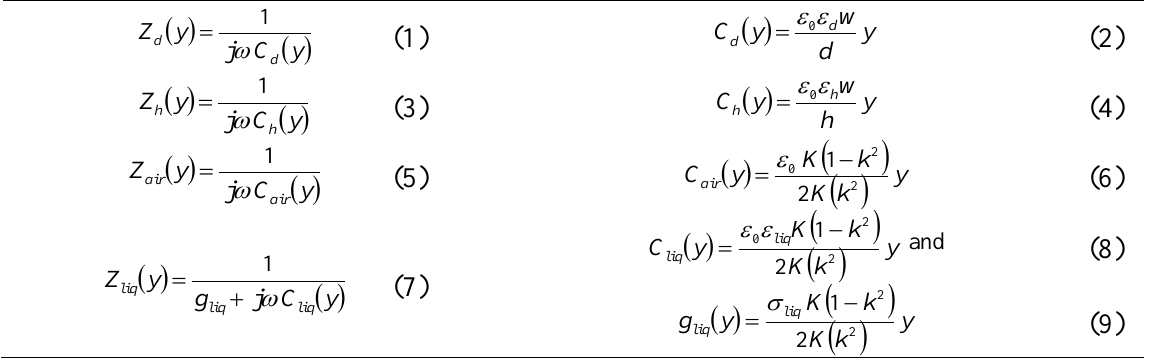
Table 1. List of the impedances and capacitances describing the LDEP device in Figures 1 and